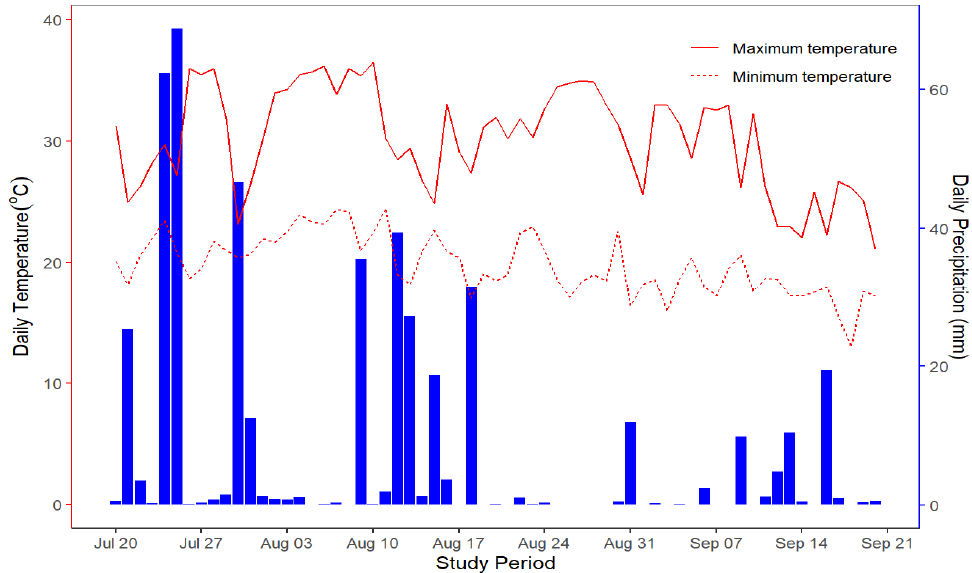
Figure 1. Variation in daily rainfall (mm) and daily maximum and minimum air temperature (°C) during the study period in Yanting, Sichuan, China in 2020.